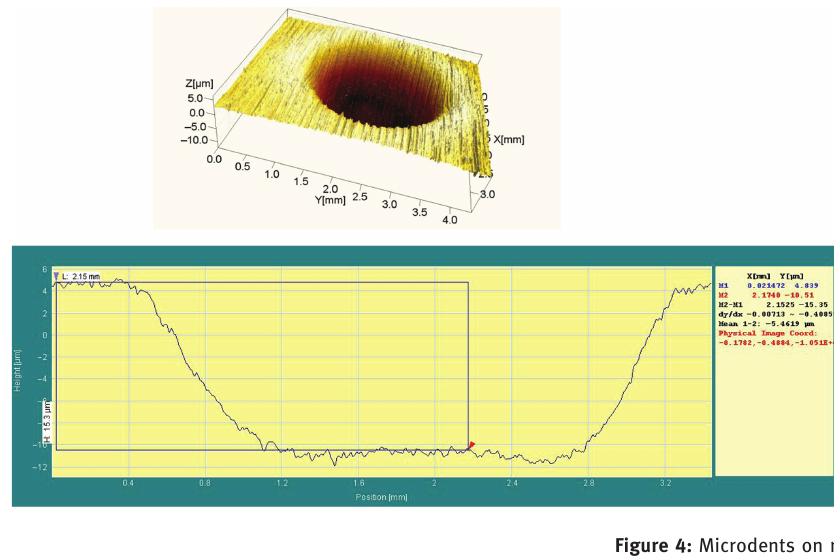
Figure 4: Microdents on material surface after LSP treatment.